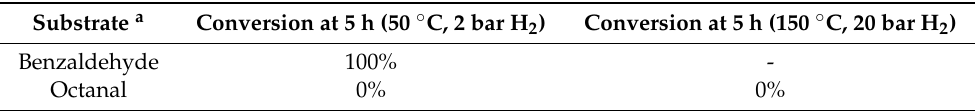
Table 3. Summary of the catalytic behaviour of 1% Pd/GNP towards aldehydes hydrogenation (50–150 ◦ C and 2–20 bar of H 2 ). Substrate